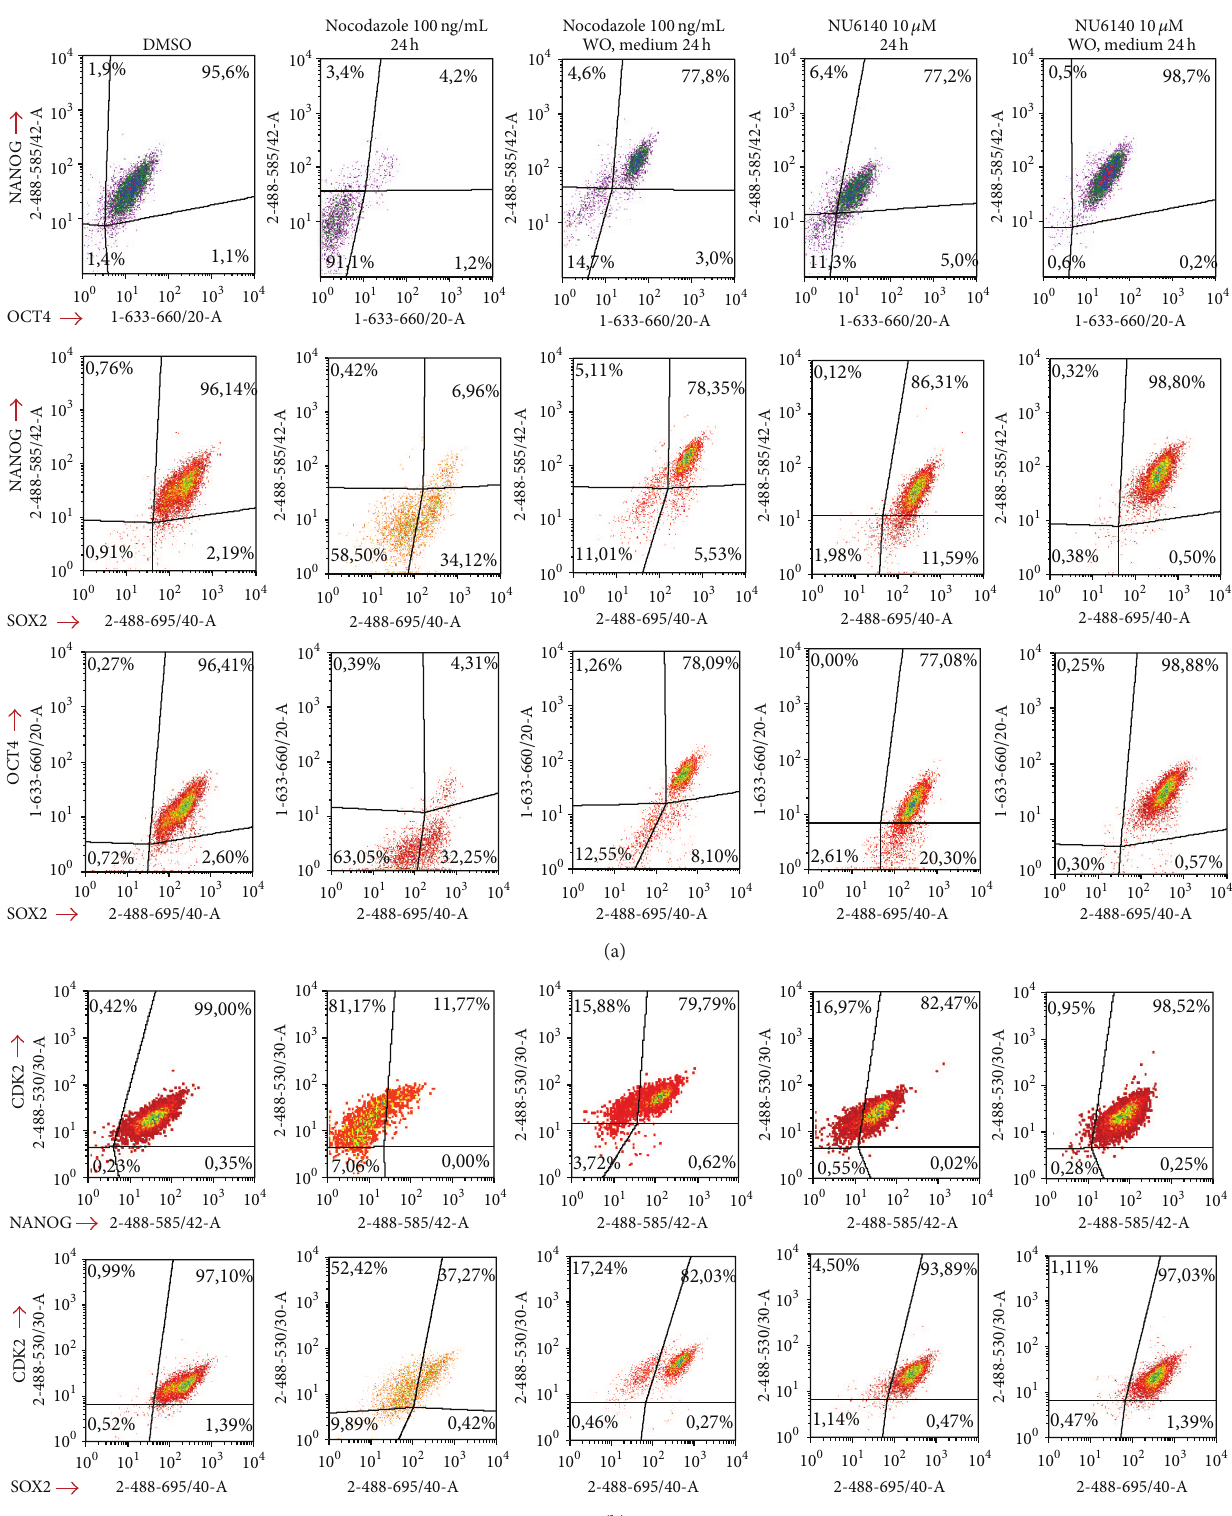
Figure 1: NU6140 treatment compared to nocodazole treatment affects differently the expression of pluripotency markers in hES cells. (a) Flow cytometric analysis of the expression of pluripotency markers NANOG, OCT4, and SOX2 in hES cells treated with nocodazole, NU6140, and DMSO. Fixed and permeabilised cells were stained with anti-NANOG (PE), anti-OCT4 (Alexa Fluor 647), and anti-SOX2 (PerCp Cy5.5 conjugate) antibodies and with DAPI. For analysis cellular debris and doublets were excluded. (b) Correlation between expression of CDK2 with NANOG and SOX2. Fixed and permeabilised cells were stained with anti-CDK2 (Alexa Fluor 488 conjugate), anti-NANOG (PE), and anti-SOX2 (PerCp Cy5.5 conjugate) antibodies and with